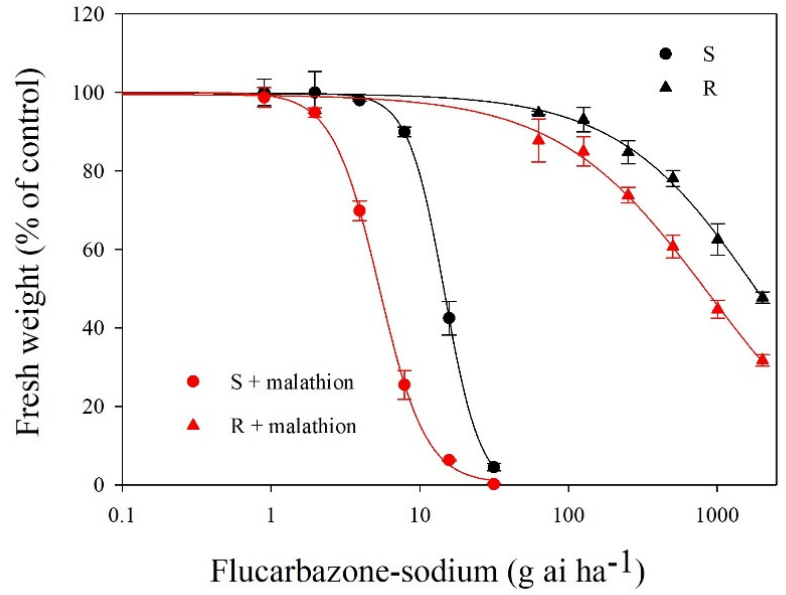
Figure 2. Dose-response curves of the plant growth of the B. japonicus populations. Vertical bars indicate the SEs (all R 2 > 0.99).